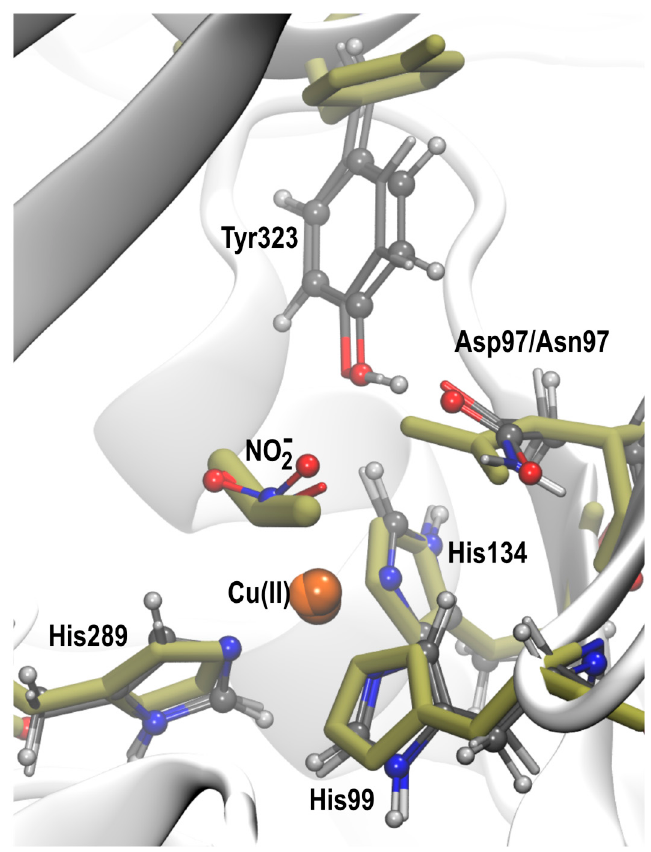
Figure 5. Superposition of the NO 2 − bound X-ray structure of D97N Rp NiR (olive sticks) and two L -shaped N-bound conformers, obtained by simulations from an initially N-bound NO 2 − to the Cu(II) state in the D97 and D97N systems.